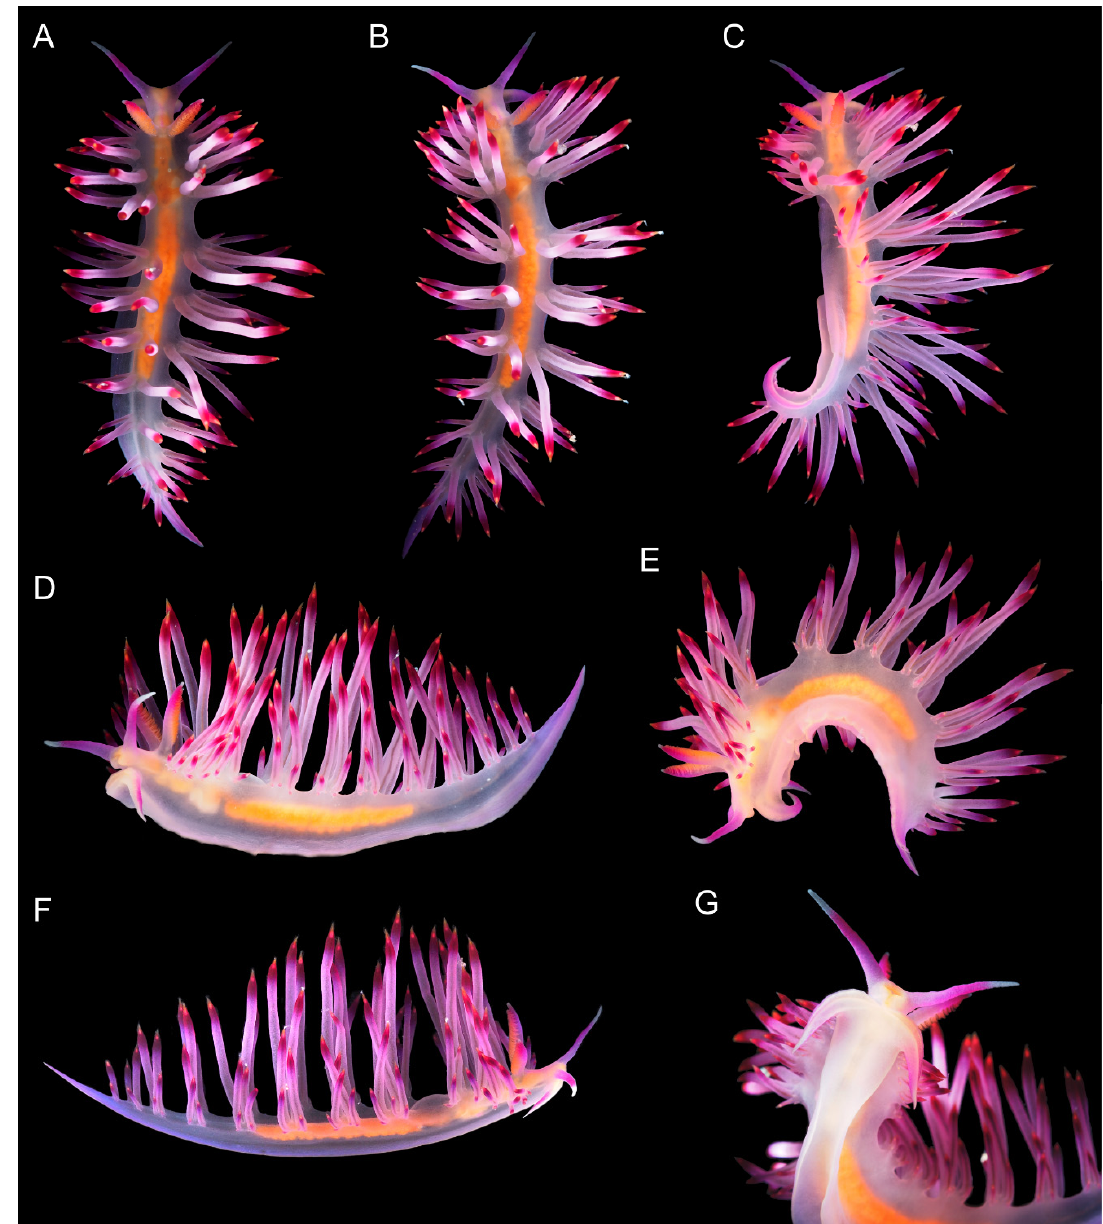
Figure 12. Coryphellina aurora sp. nov., holotype ZIN63224, specimen 27 mm in length (preserved), external morphology. ( A – C )—dorsal view. ( D , E )—lateral view from left. ( F )—lateral view from right. ( G )—ventral view on anterior body part. Photo credit: Yury Deart.